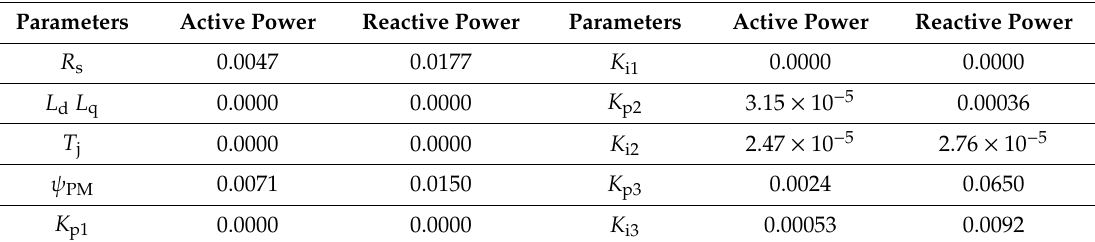
Table 4. Average trajectory sensitivity of parameters when voltage dips about